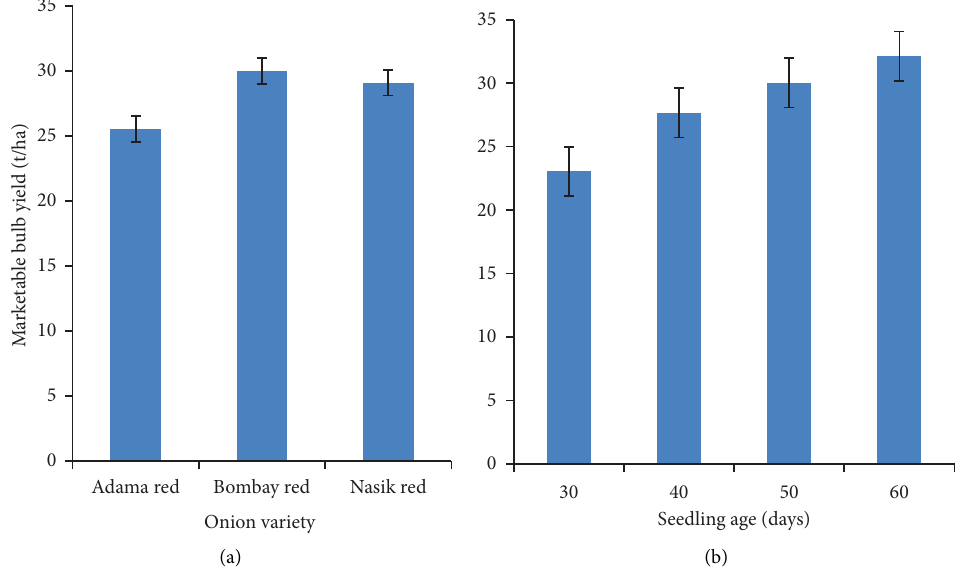
Figure 5: Efect of variety (a) and seedling age (b) on bulb yield of